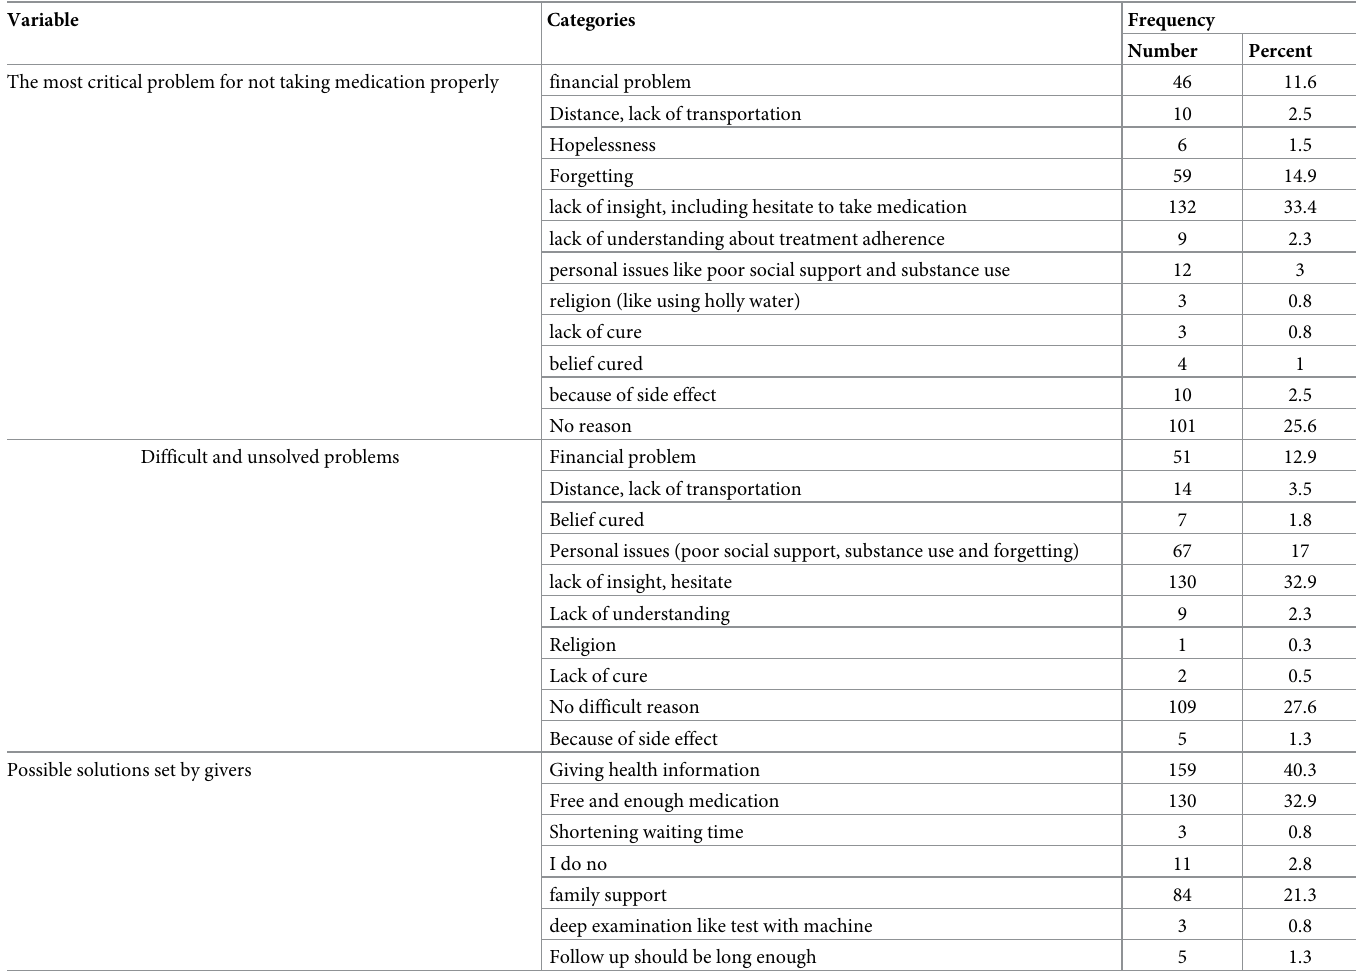
Table 5. Frequency distribution of respondents by their caregivers stated factors at Asella Referral and Teaching Hospital 2022. Variable The most critical problem for not taking medication properly